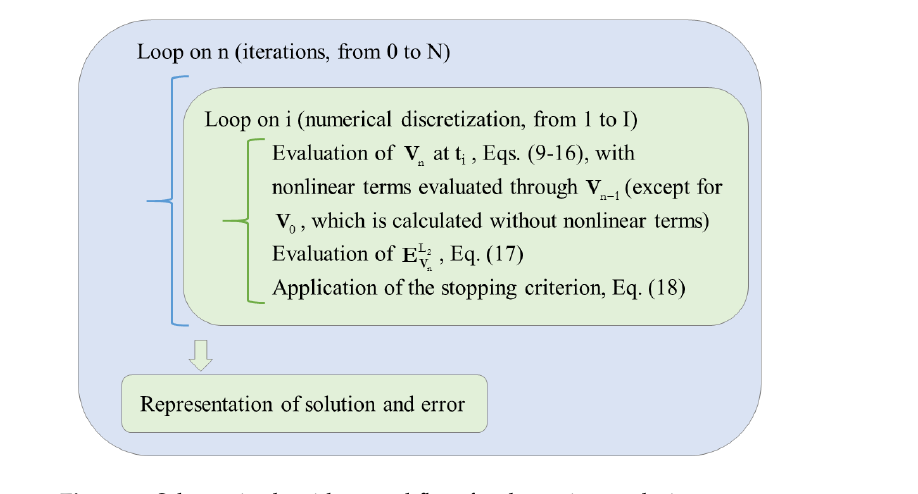
Figure 1. Schematic algorithm workflow for the entire resolution process.